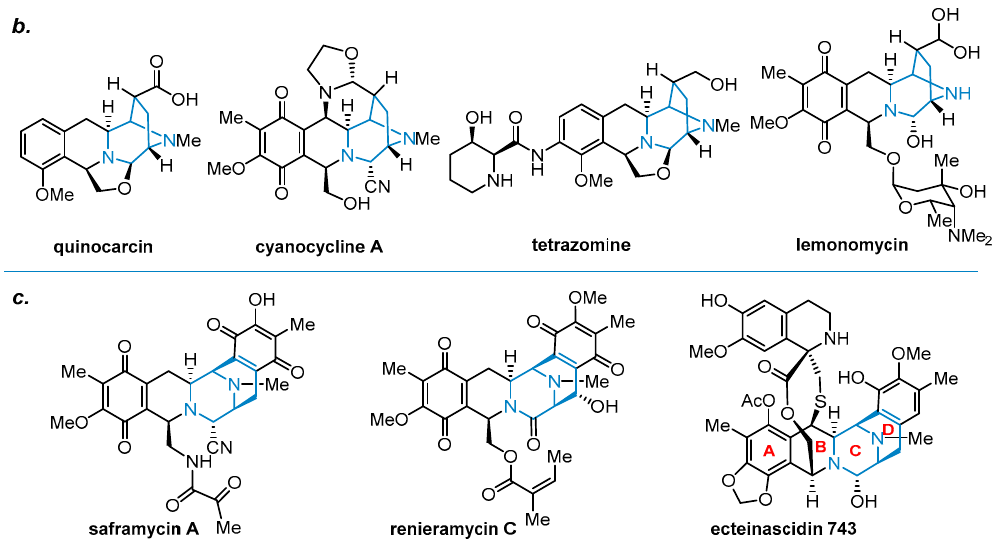
Figure 2. Representative THIQ antitumor antibiotics and mode of action (MoA). ( a ) Mode of action (quinocarcin as example); ( b ) THIQs bearing a diazabicyclo [3.2.1]octane core; ( c ) THIQs bearing a diazabicyclo [3.3.1]nonane core.